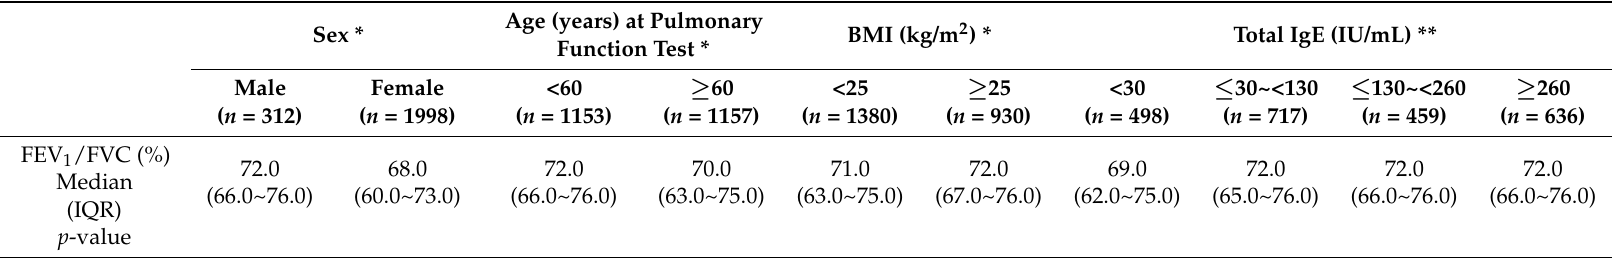
Table 2. Distributions (median (IQR)) of FEV 1 /FVC (%) according to sex, age, BMI, or total IgE level in neversmoking asthmatics ( n = 2310